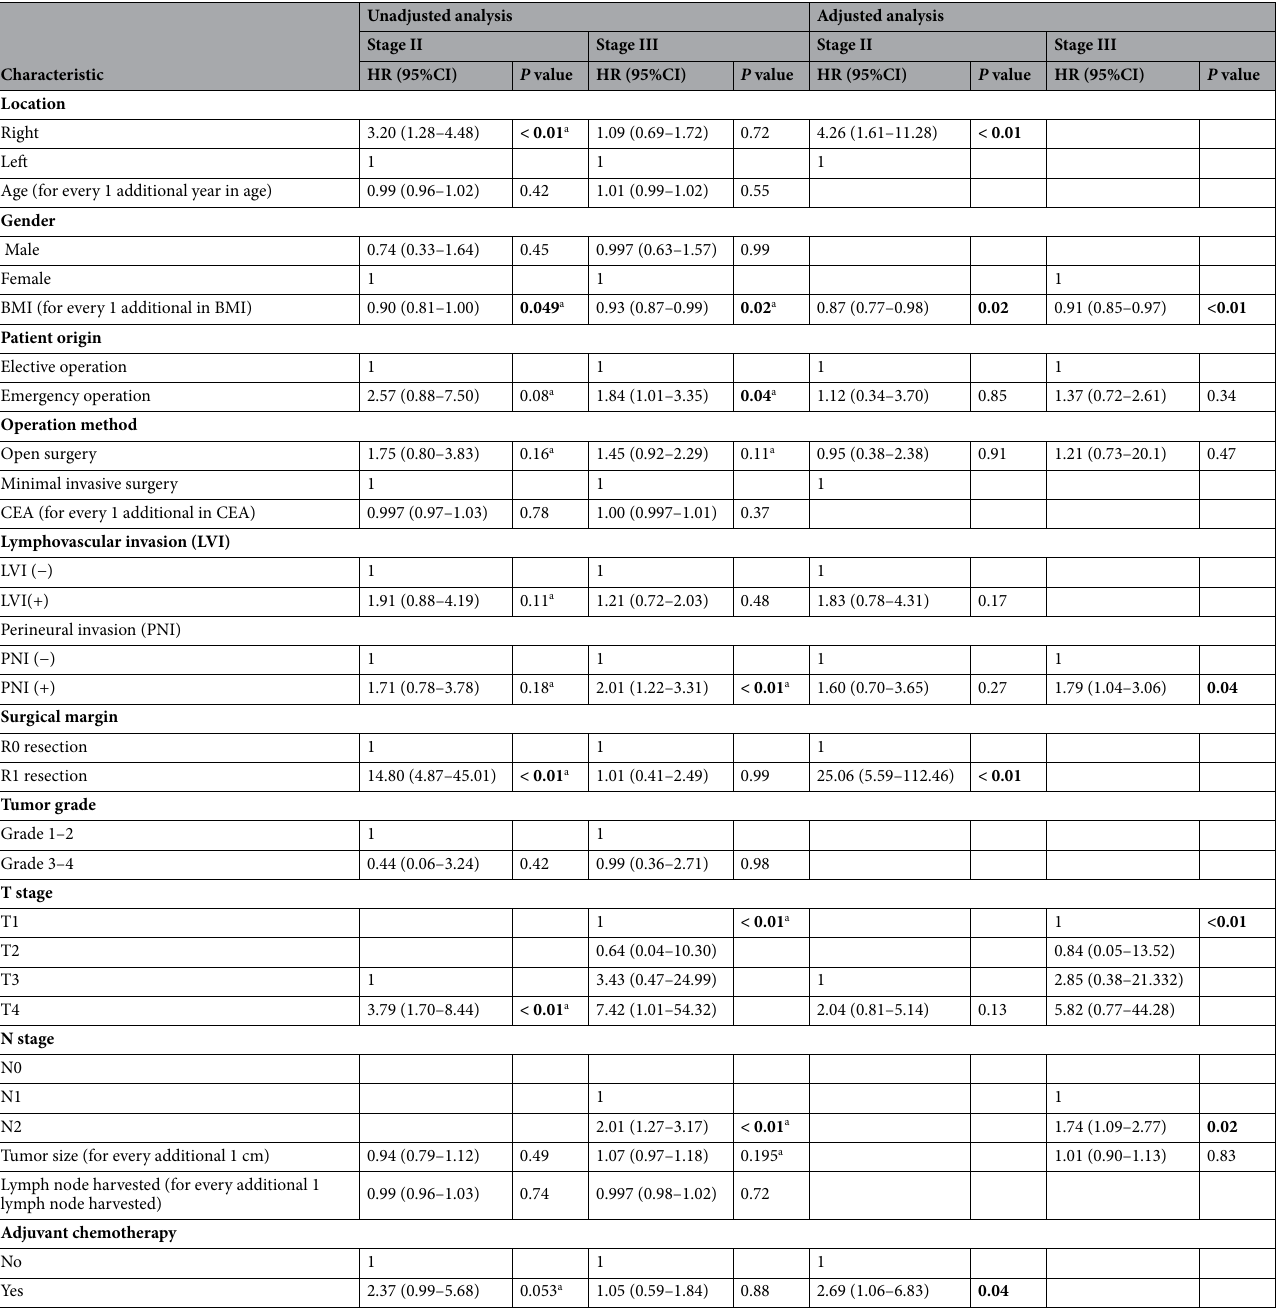
Table 5. Univariate and multivariate analysis a for TTR by Cox Proportional Hazards Regression in stage II and stage III colon cancer after PSM. Significant values are in bold. BMI Body mass index, CEA carcinoembryonic antigen. a Only variables with p<0.2 in univariate analysis were included to multivariate